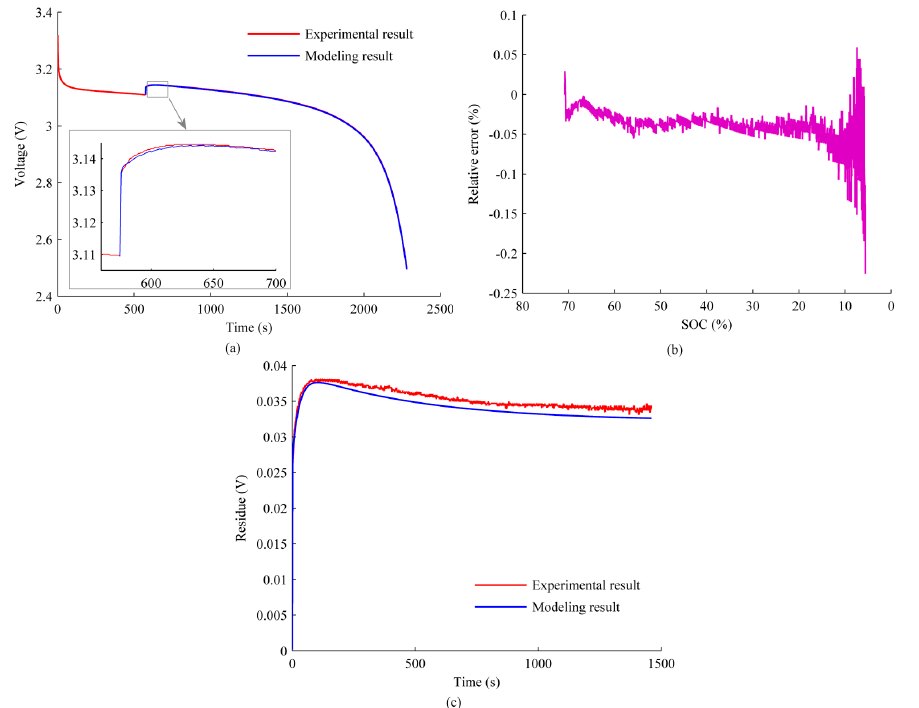
Figure 11. Modeling result under { i 1 = − 13 A, i 2 = − 10 A, SOC j = 71%}: ( a ) Terminal voltage curve estimation; ( b ) Relative error; ( c ) Residue curve.